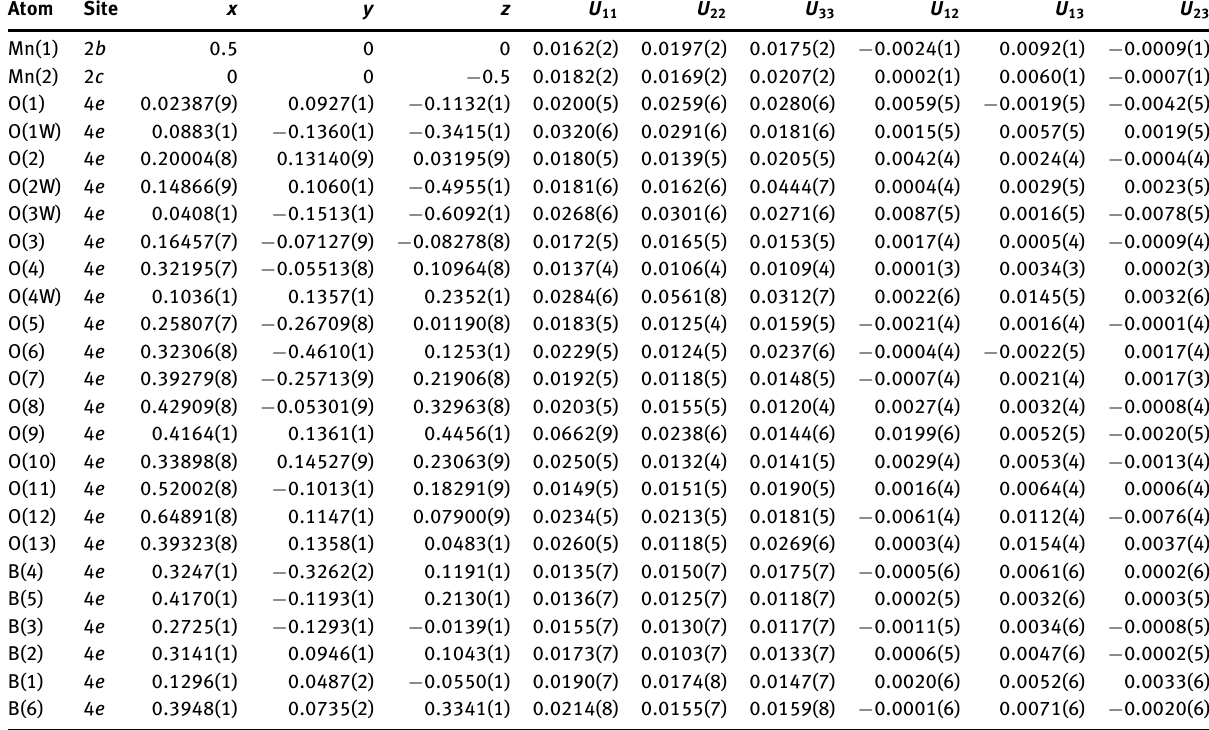
Table 3: Atomic displacement parameters (Å 2